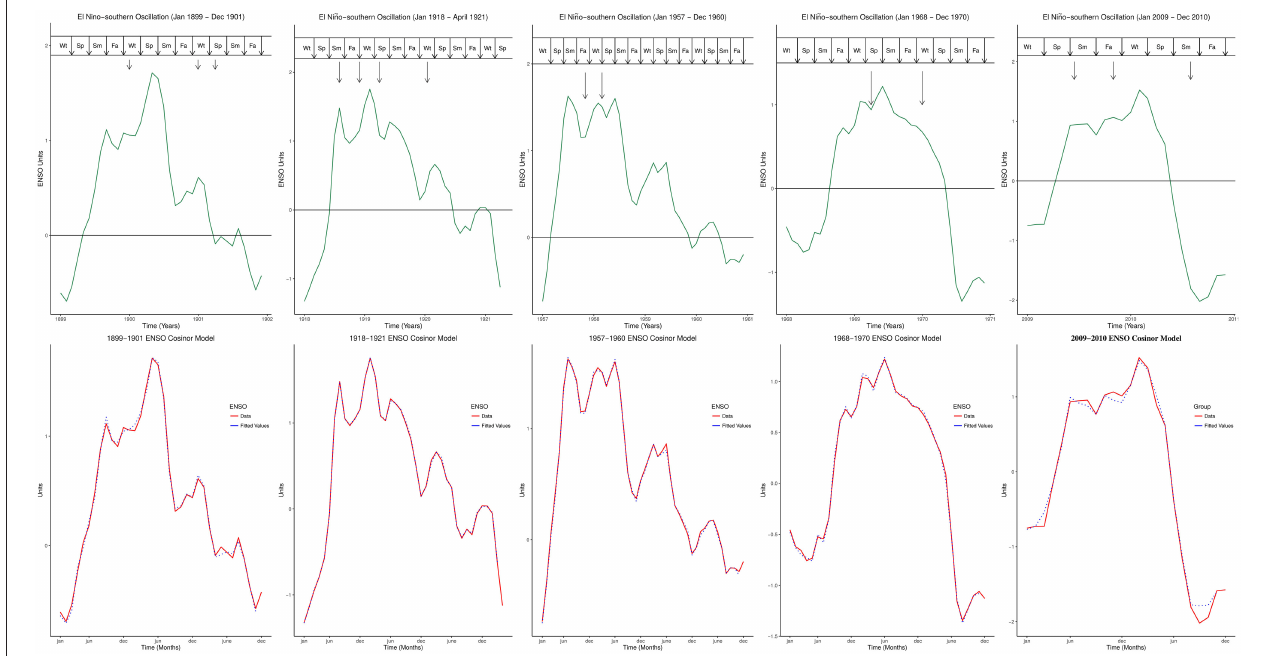
FIGURE 1 | Peaks of influenza Pandemics, El Niños, and Cosinor models. Wt, Winter; Sp, Spring; Sm, Summer; Fa, is Fall.